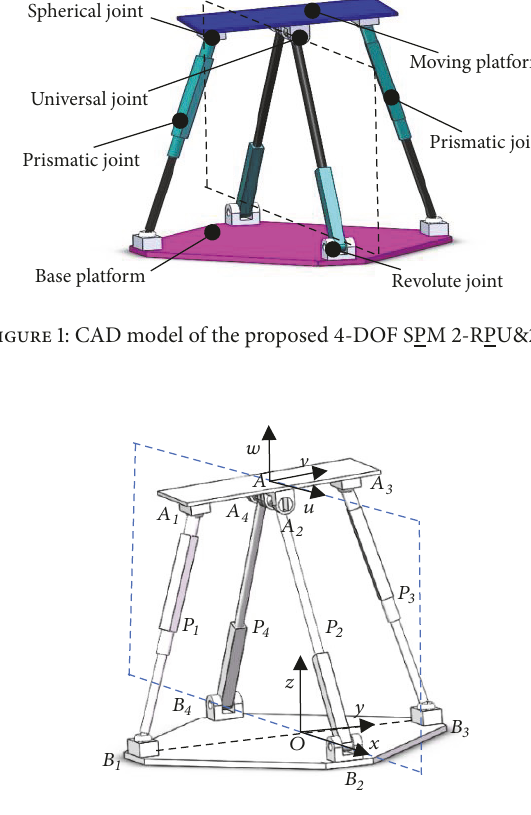
the 𝑧 axis is perpendicular to the base platform. The moving frame 𝐴 − 𝑢 V 𝑤 is established on the moving platform, where point 𝐴 is the center of the moving platform, the 𝑢 axis is collinear with 𝐴 2 𝐴 4 and points from point A to point 𝐴 2 , the 𝐴 V axis is collinear with 𝐴 1 3 and points from point 𝑤 axis is perpendicular to the moving platform. 𝐴 3 , and the Here, 𝐵 2 and 𝐵 4 are the rotational axes of the revolute joints, 𝐴 𝐵 𝐵 𝐴 1 , 3 , 1 , and 3 are the centers of the spherical joint, and 𝐴 𝐴 2 and 4 , respectively, represent the universal joints